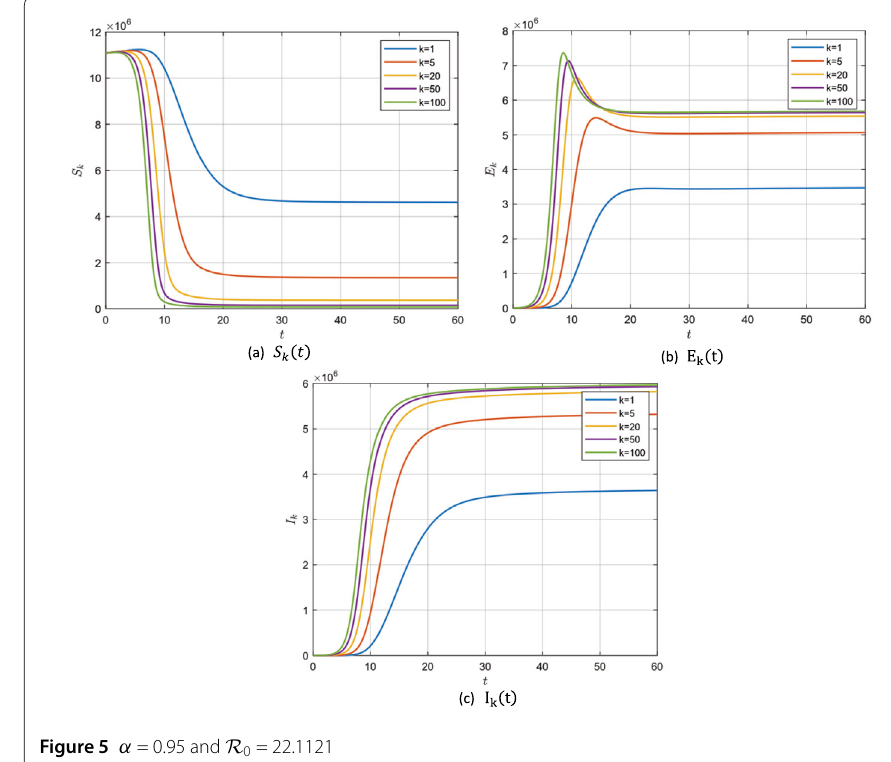
Figure 5 α = 0.95 and R 0 = 22.1121